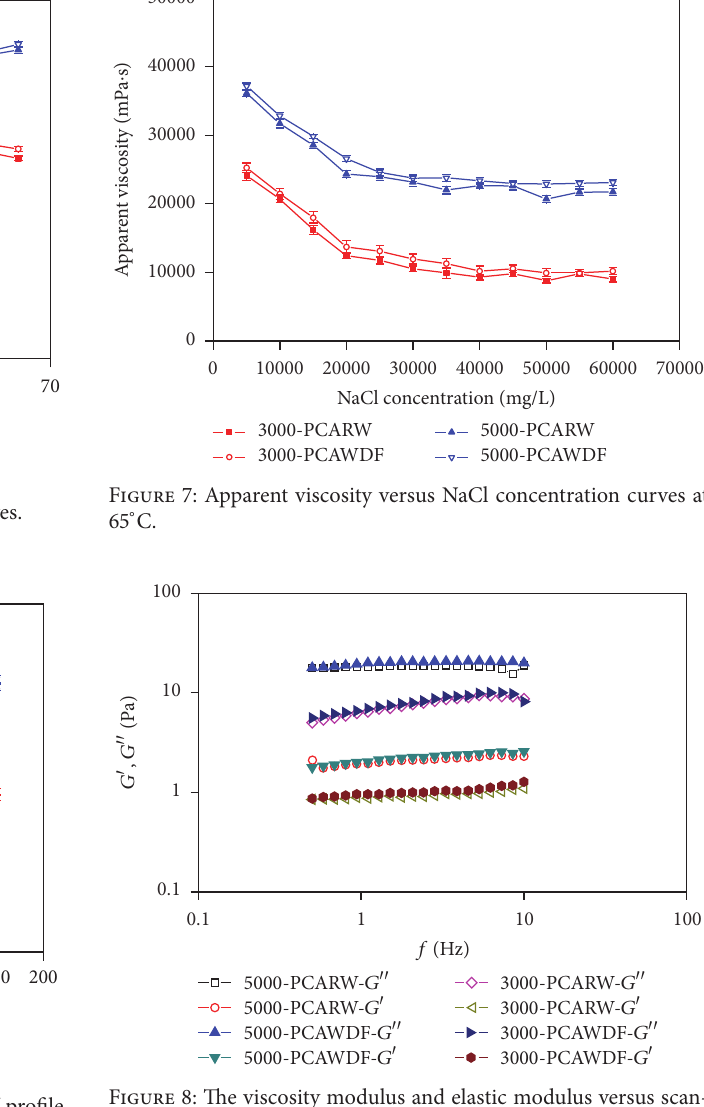
Figure 6: Apparent viscosity versus temperature curves of profile control agents.